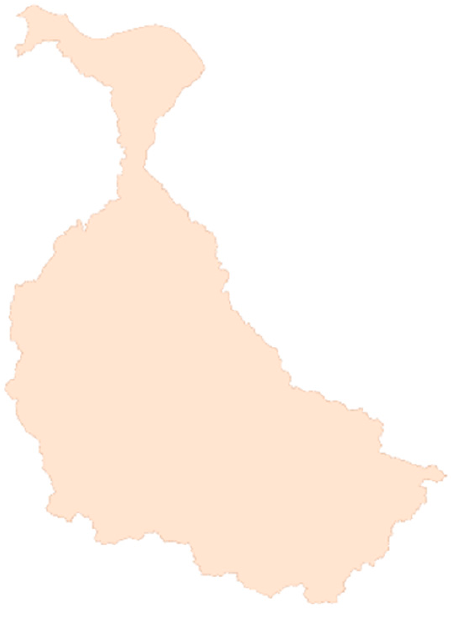
Figure 4. Digital Image of Citarum Watershed [37].